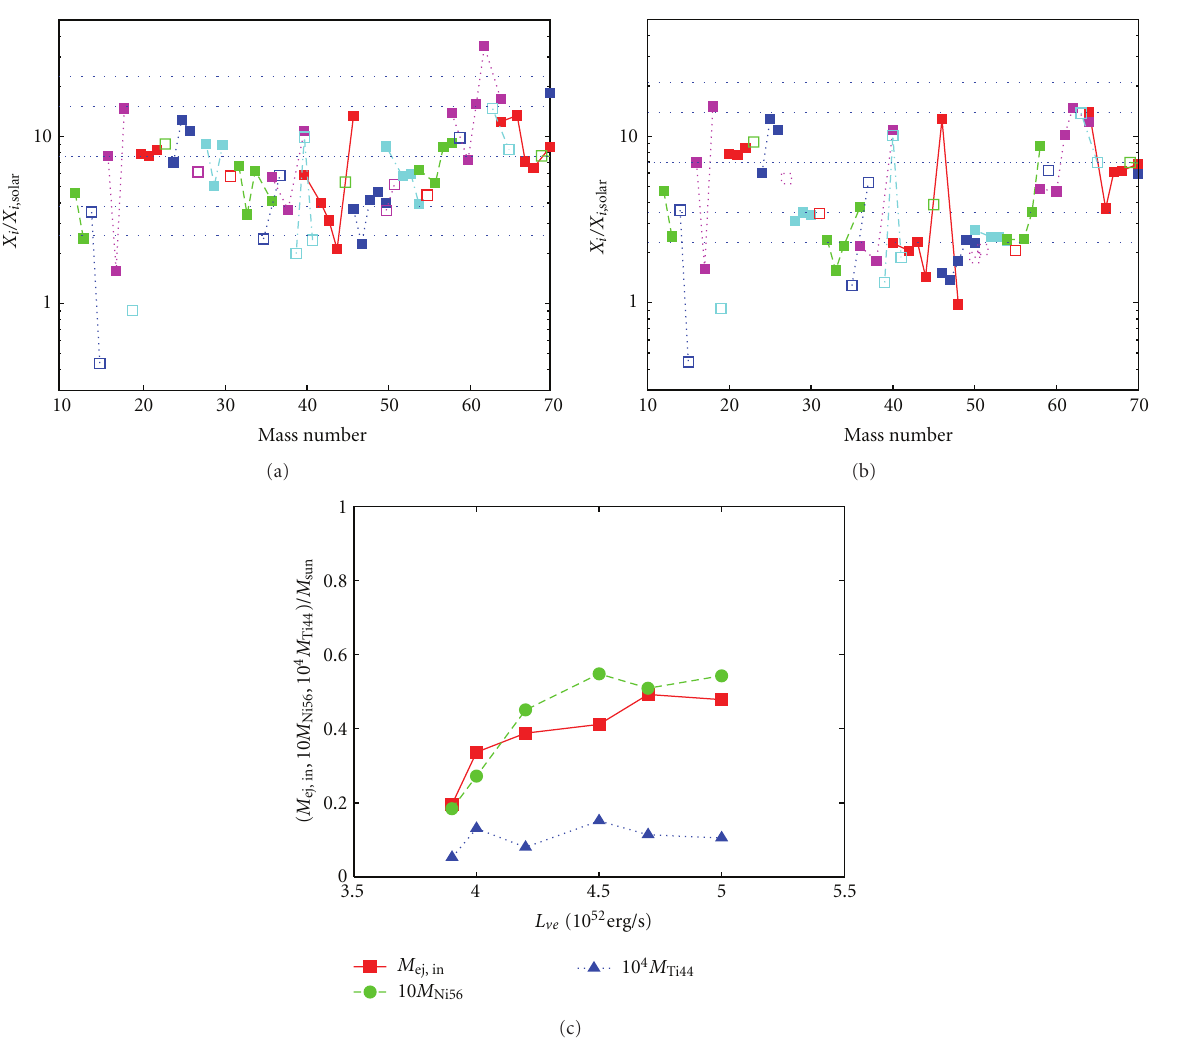
Figure 16: Bottom panel shows masses of ejecta ( M ej,in ) and masses of radioactives ( 56 Ni and 44 Ti) as a function of the input neutrino luminosity. Top and middle panels show element abundance yields ( X i /X (cid:3) , i , normalized to solar) versus mass number for our reference model of L ν e = 4 . 5 × 10 52 ergs − 1 and for the middle panel L ν e = 3 . 9 × 10 52 ergs − 1 , respectively. Thick horizontal-dashed lines represent a factor equals to that of 16 O, while two normal and two thin lines denote a factor equals to that of 16 O times 2, 1/2, 3, and 1/3, respectively. These figures are taken from